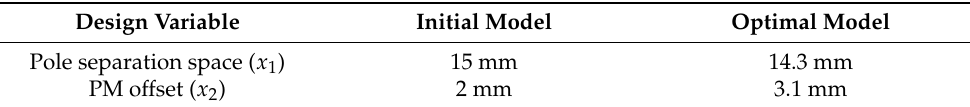
Table 7. Final optimal results.